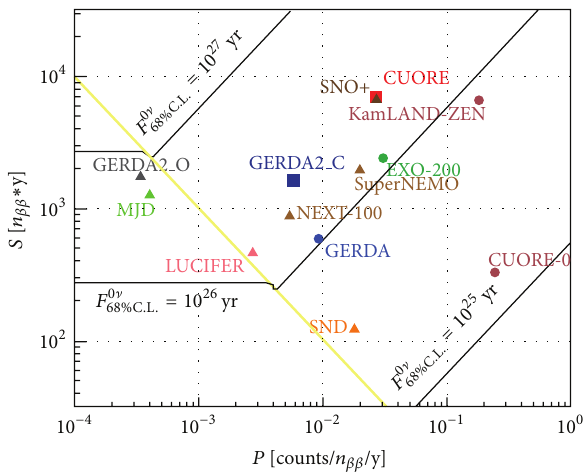
Figure 16: Comparison of the sensitivities of future 𝛽𝛽(0 ] ) projects (Figure from [68]). Isosensitivities curves are shown in the Scale versus Performance plane (see text for the definition of these two parameters). The yellow thick line highlights the transition to the zero background region (which is reached by GERDA II in the optimistic background configuration, MJD, and Lucifer). Data are from Table